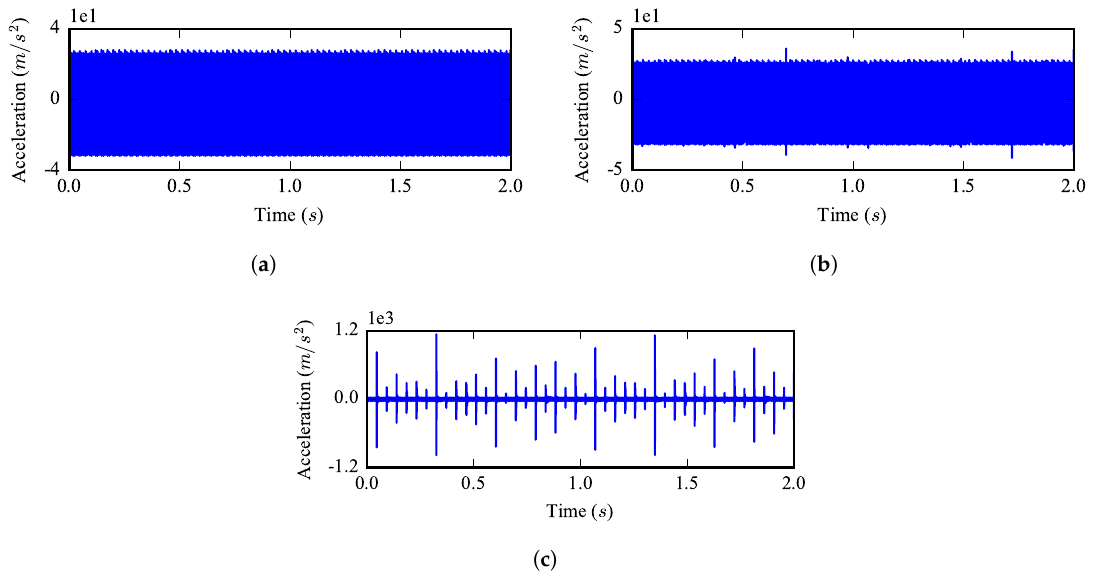
Figure 7. Waveform of the simulated ring acceleration of the ( a ) healthy gear p = 0, ( b ) half tooth breakage fault gear p = 0.2 and ( c ) the whole tooth breakage fault p =